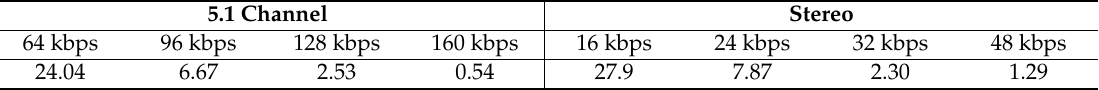
Table 10. Averaged BER (%) of test multichannel audio under various bit rate HE-AAC compressions.